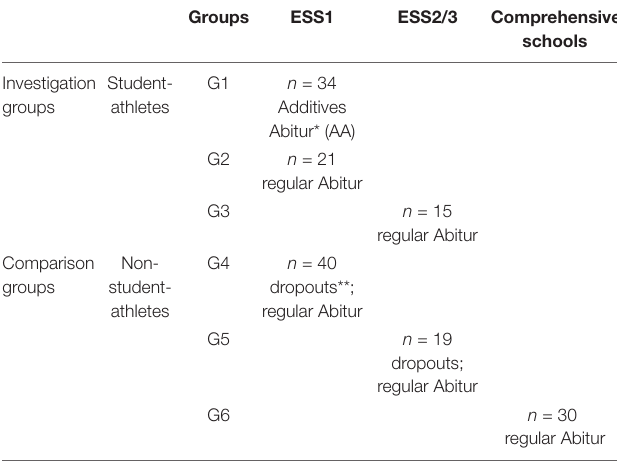
TABLE 2 | Grouping details of the